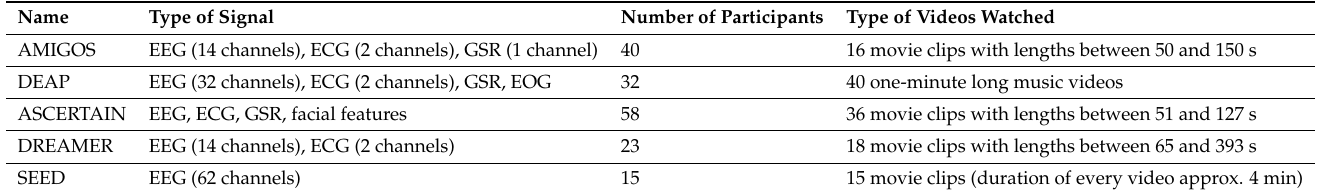
Table 2. Basic description of five multimodal affective